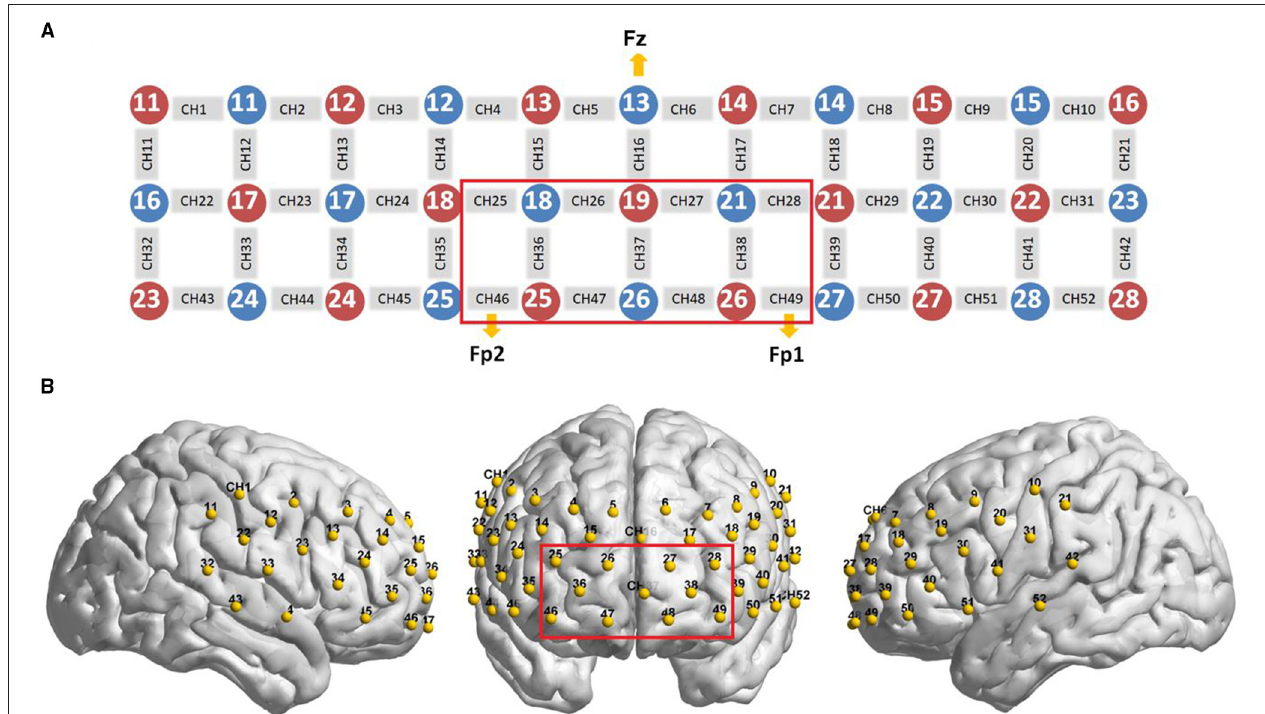
FIGURE 3 | Optode probe set. (A) A “3 × 11” measurement patch set with 17 emitter and 16 detector probes positioned alternatively is shown; when the detector number 13 was located at Fz, channels 49 and 46 were placed in FP1 and FP2, respectively. (B) The optode probe was placed on the pre-frontal and temporal cortex. The red frame denotes regions of interest.